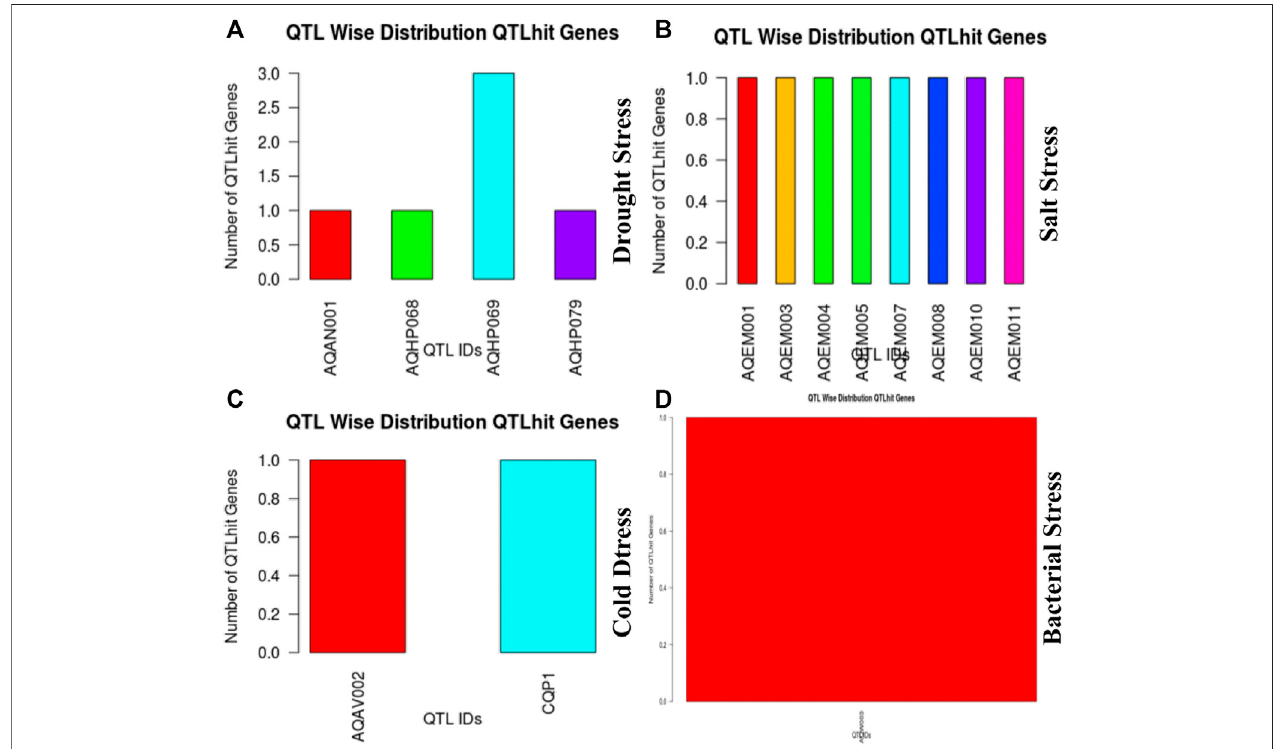
FIGURE 8 | Hub gene distribution on chromosome to the corresponding QTL